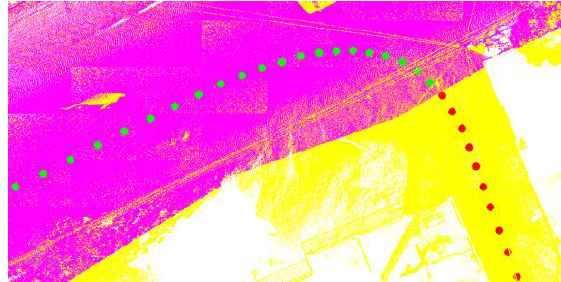
Figure 9. Overlapping area of main road cloud (purple) and a crossing street (yellow).